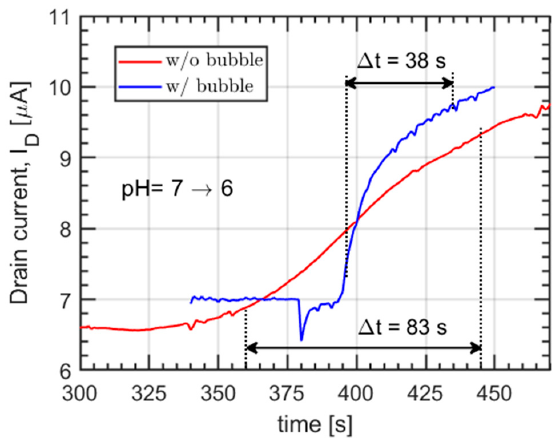
Figure 4. Comparison between the drain current, I D , response over time with and without the employed air bubble strategy to prevent interdiffusion. The 10% to 90% transition times are indicated in the plot with dashed lines, for the two cases, respectively.